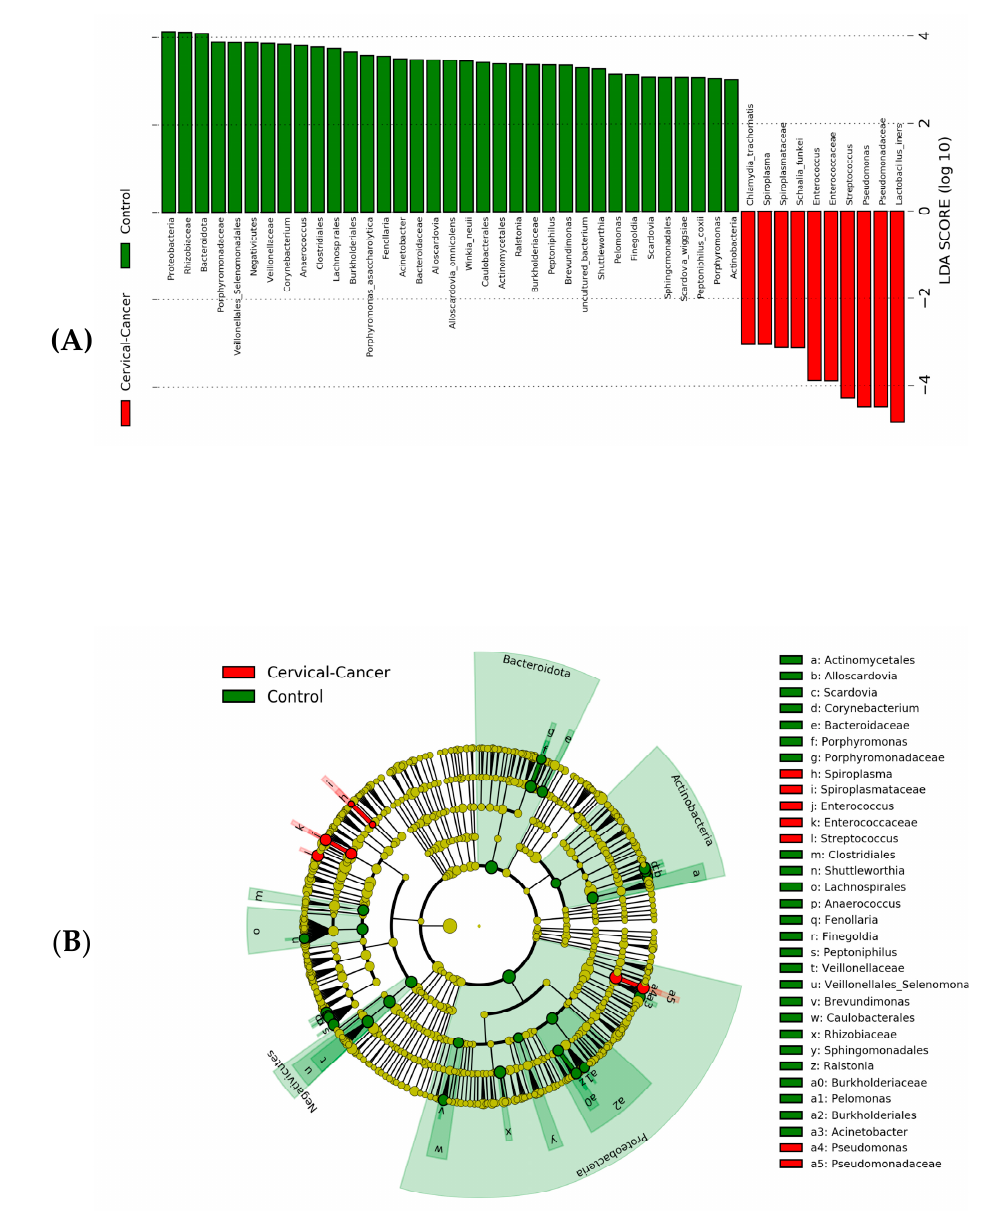
Figure 8 . Linear discriminant analysis (LDA) effect size (LEfSe) analysis for vaginal microbiota abundance in cervical cancer and healthy control groups. ( A ) The Bar plot from LEfSe analysis indicates the enriched bacteria that are associated with cervical cancer (red) and healthy control (green) groups. ( B ) A phylogenetic cladogram plot from LEfSE analysis representing the differentially abundant taxa at various taxonomic levels (LDA score > 3.0).